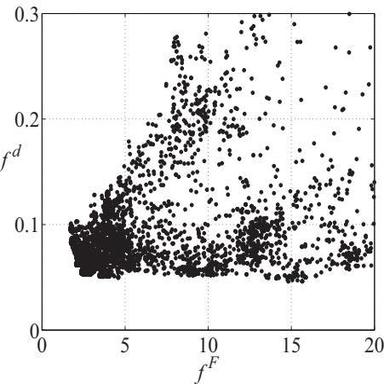
Multi-objective results using VTM model.